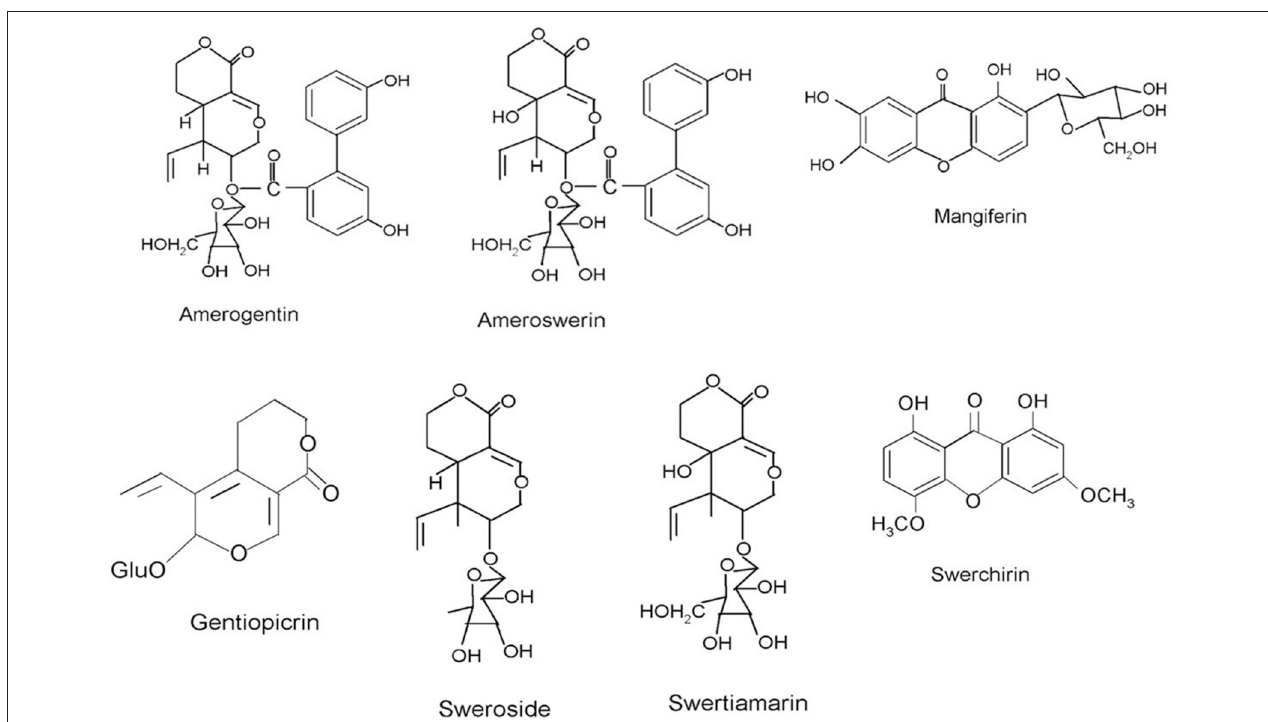
FIGURE 3 | Chemical structures of important phytoconstituents found in Swertia chirayita